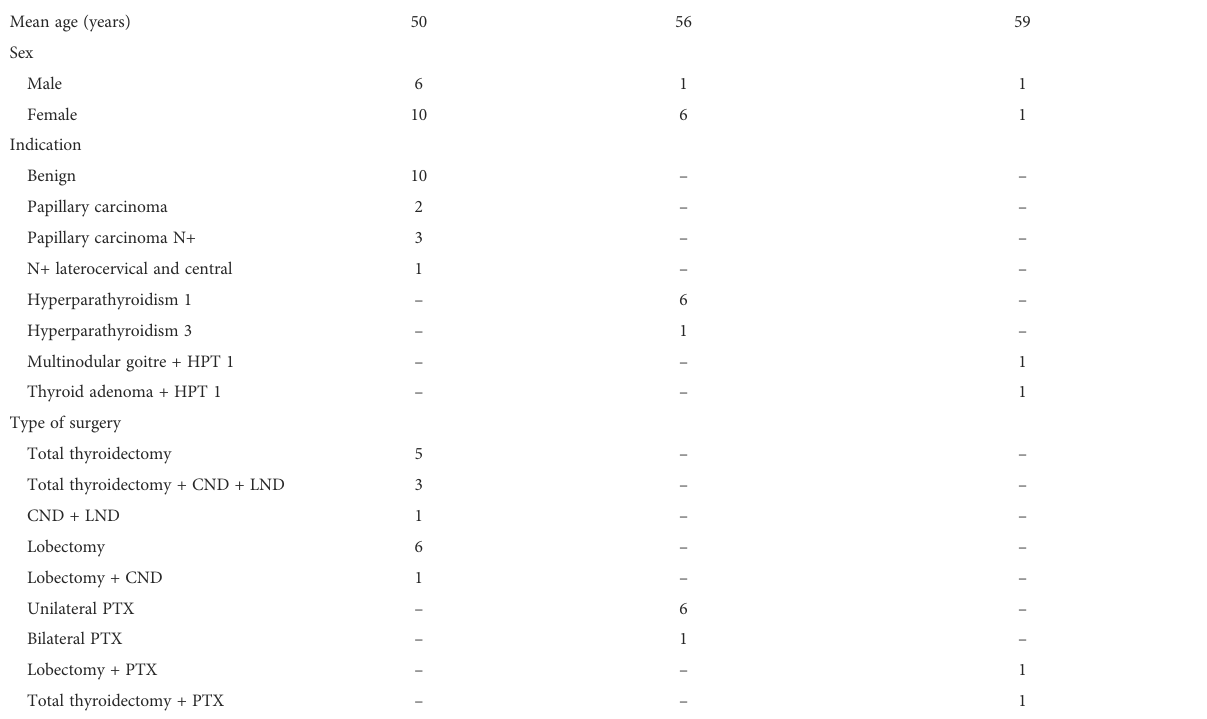
TABLE 1 Demographic and surgery characteristics of patients who underwent thyroid and/or parathyroid